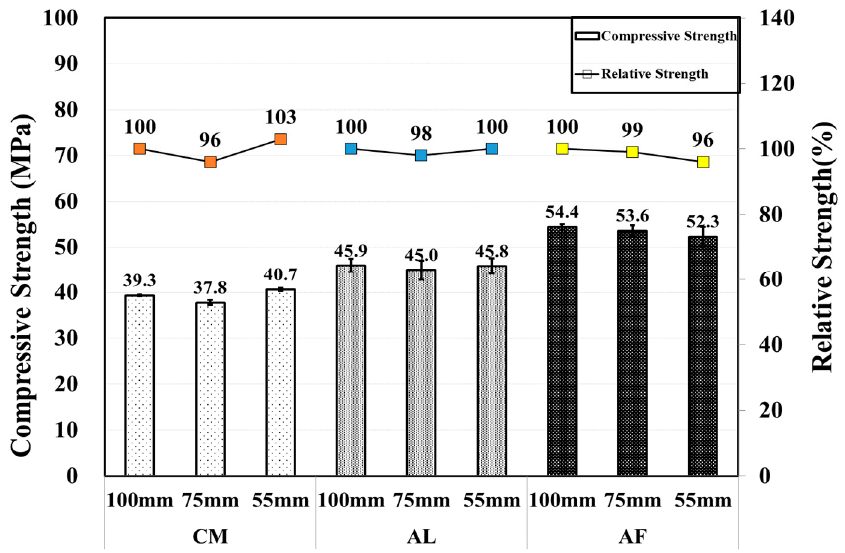
Figure 6. Core compressive and relative strength of SH specimens by accelerators for 3 month-old specimens.